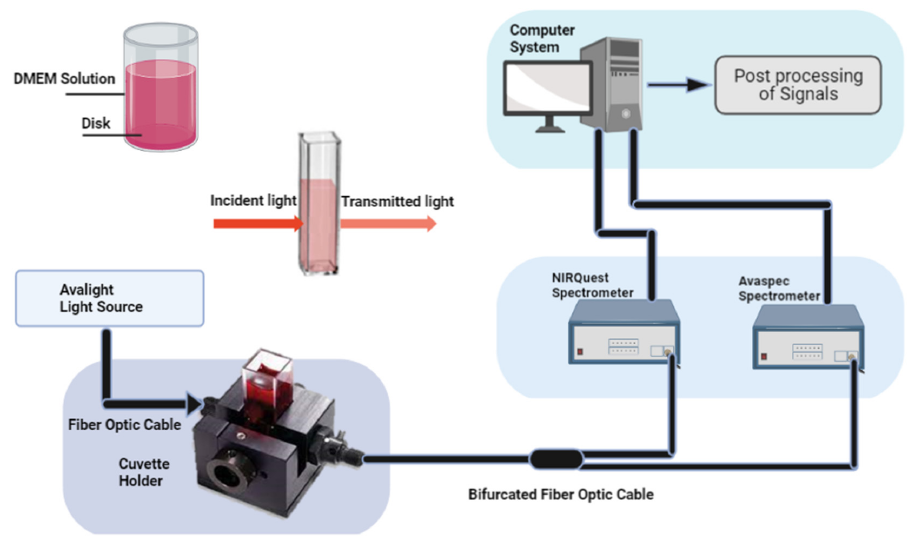
Figure 8. Illustration of NIRS optical setup. A cuvette holder is used to hold the solution for absorption and transmission measurements.